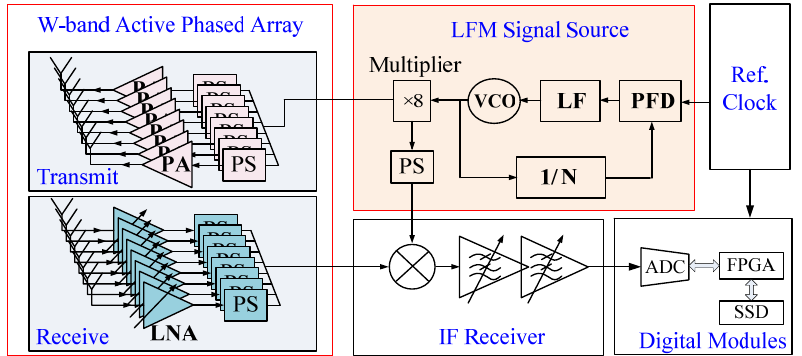
Figure 1. The schematic of the proposed W-Band APA mini-SAR system.